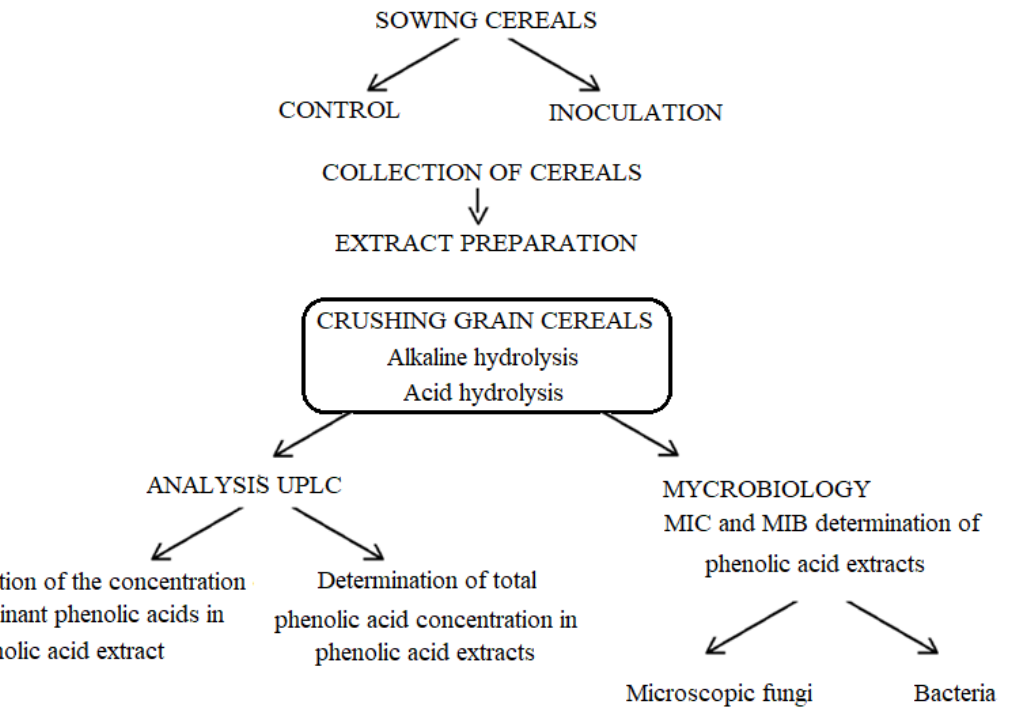
Figure 1. Course of experiments.